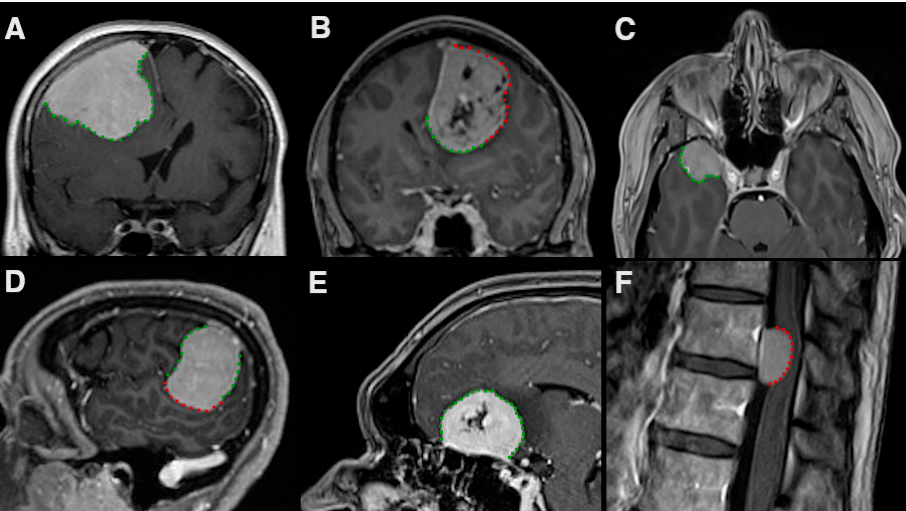
Figure 2. Illustration of the area of interest for meningioma sampling regarding the detection of CNS invasion. Dotted lines represent contact of the meningioma surface with non-eloquent (green) and eloquent (red) parenchyma (( A ): right frontal convexity meningioma; ( B ): left frontoparietal falcine meningioma; ( C ): right-sided sphenoid wing meningioma; ( D ): left temporo-parietal convexity meningioma; ( E ): olfactory groove meningioma; ( F ): ventral thoracic meningioma).